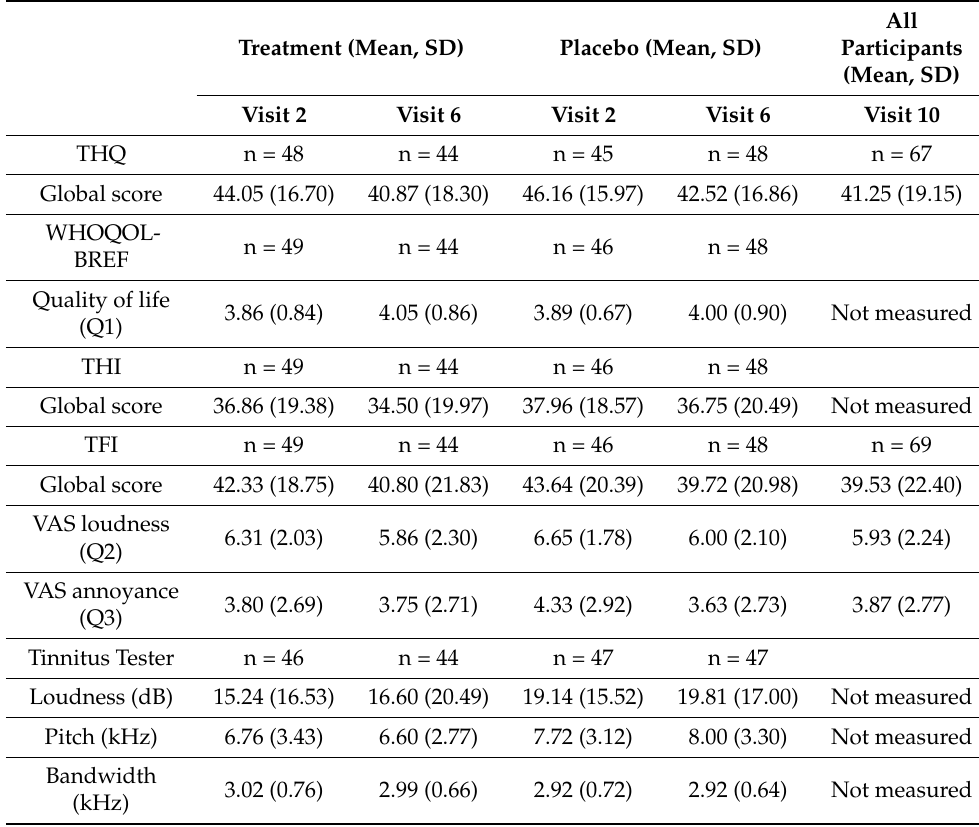
All Participants (Mean, SD)